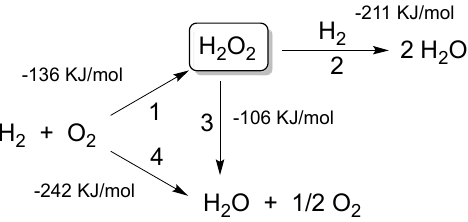
Figure 1. The different reactions involved when reacting hydrogen and oxygen.